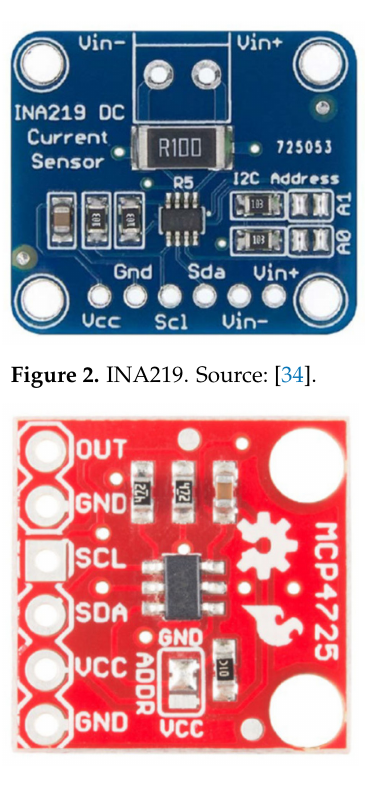
Figure 3. MCP4725. Source: